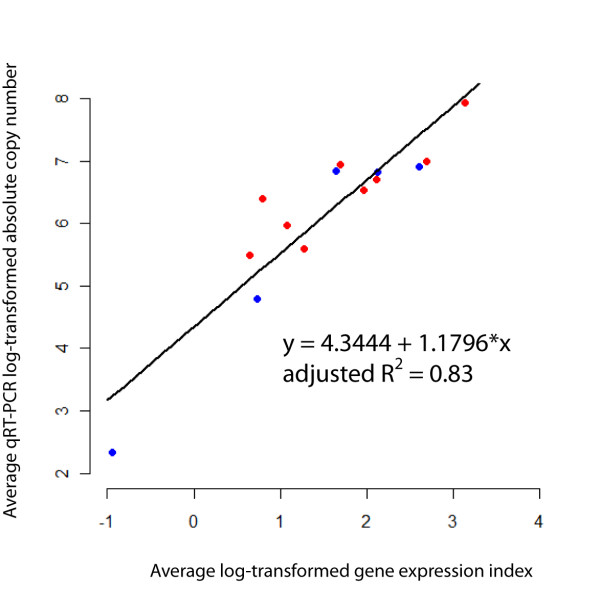
Correlation between qRT-PCR and RNA-Seq. Correlation between qRT-PCR and RNA-Seq data for selected genes in L. monocytogenes 10403S (red) and the ΔsigB strain (blue). The selected genes are: ctc, gadA, gap, opuCA, rpoB (qRT-PCR data from both strains were available for these 5 genes), flaA, inlA, plcA and sigB (only qRT-PCR data from 10403S were available for these 4 genes).